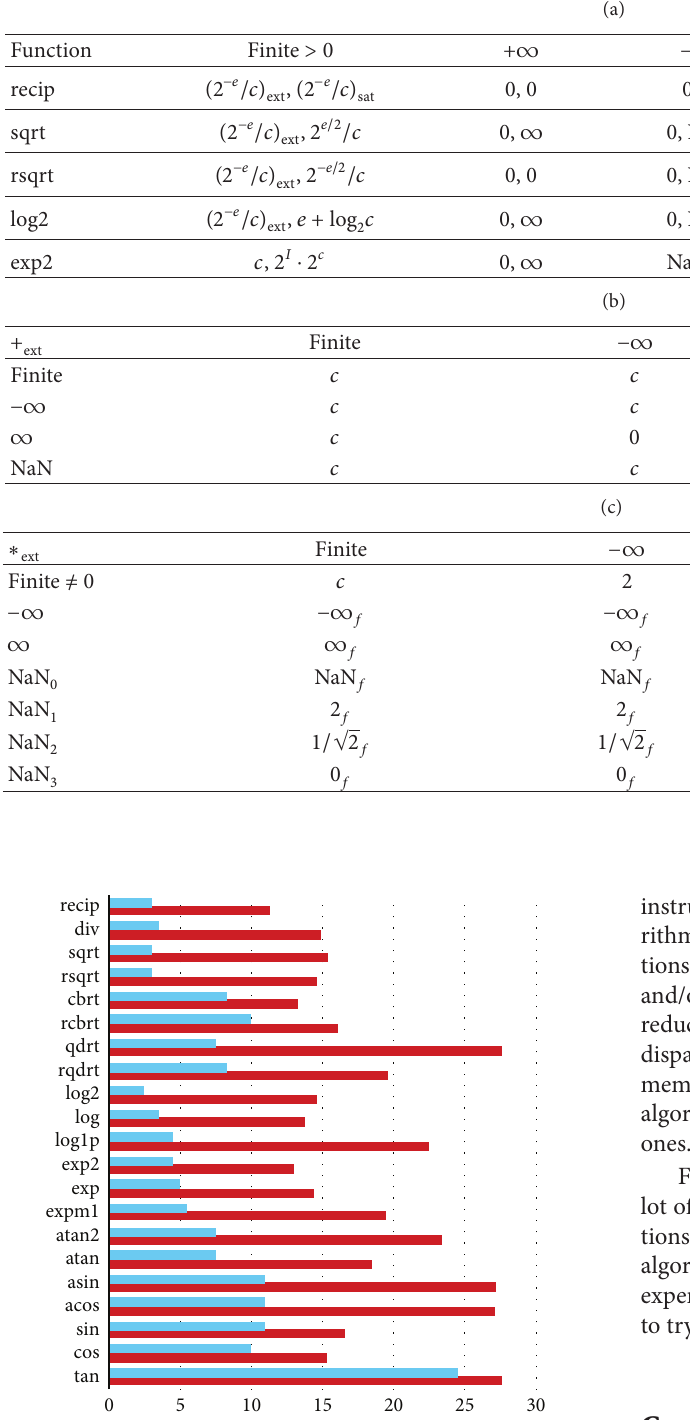
Figure 3: Throughput, measured in cycles per double, for imple- mentations of elementary function with (upper bars) and without (lower bars) the novel instructions proposed in this